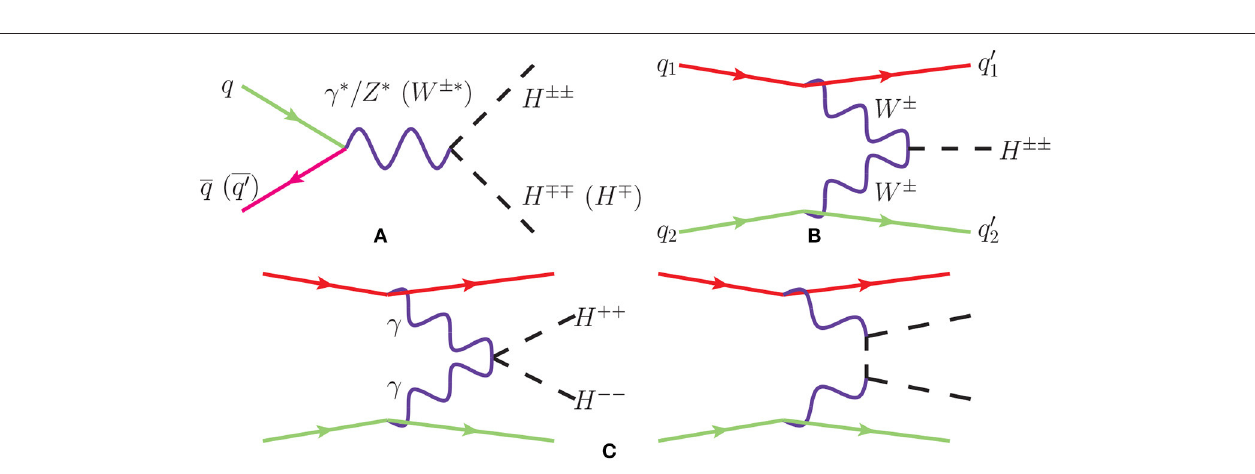
FIGURE 28 | Born-level diagrams depicting Type II triplet scalar production in pp collisions via (A) the DY mechanism, (B) same-sign W ± W ± scattering, and (C) γγ